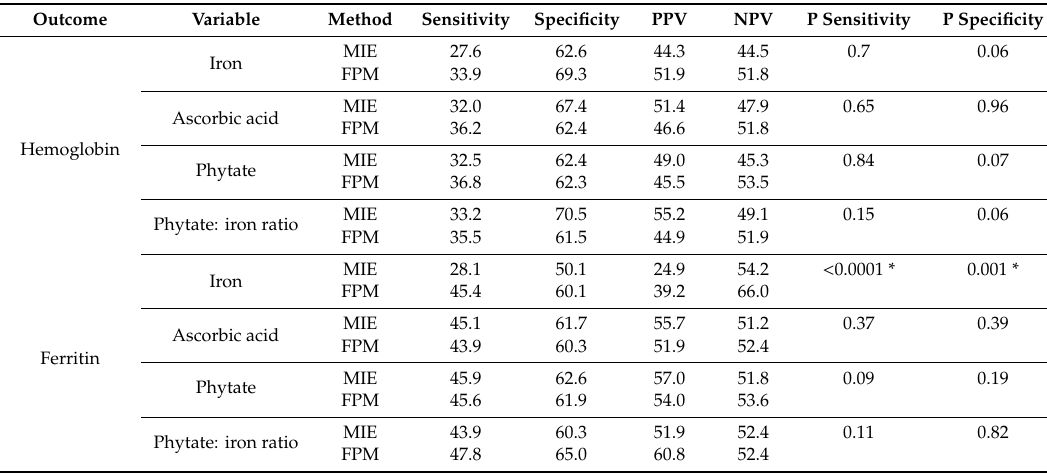
Table 6. Diagnostic accuracy of mean nutrient estimates versus food pattern modeling assessment methods for hematological indices of iron su ffi